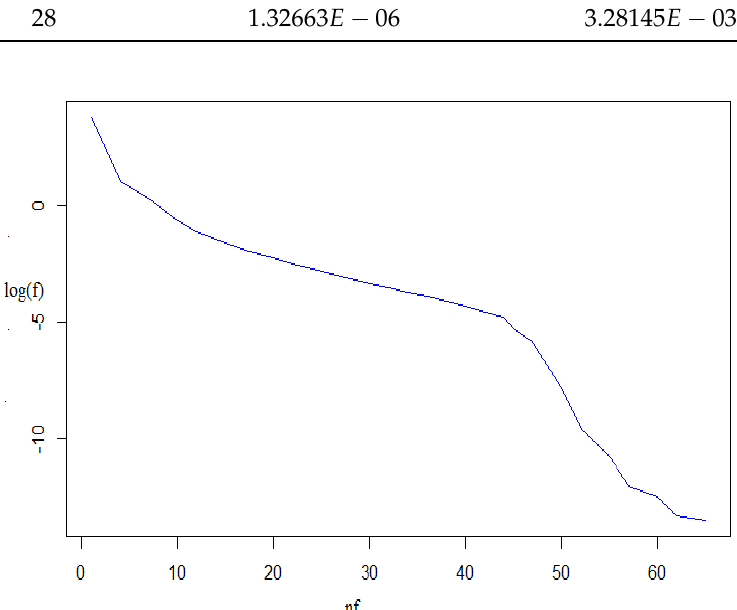
Figure 1. Number of function evaluations due to q -gradient descent algorithm for Example